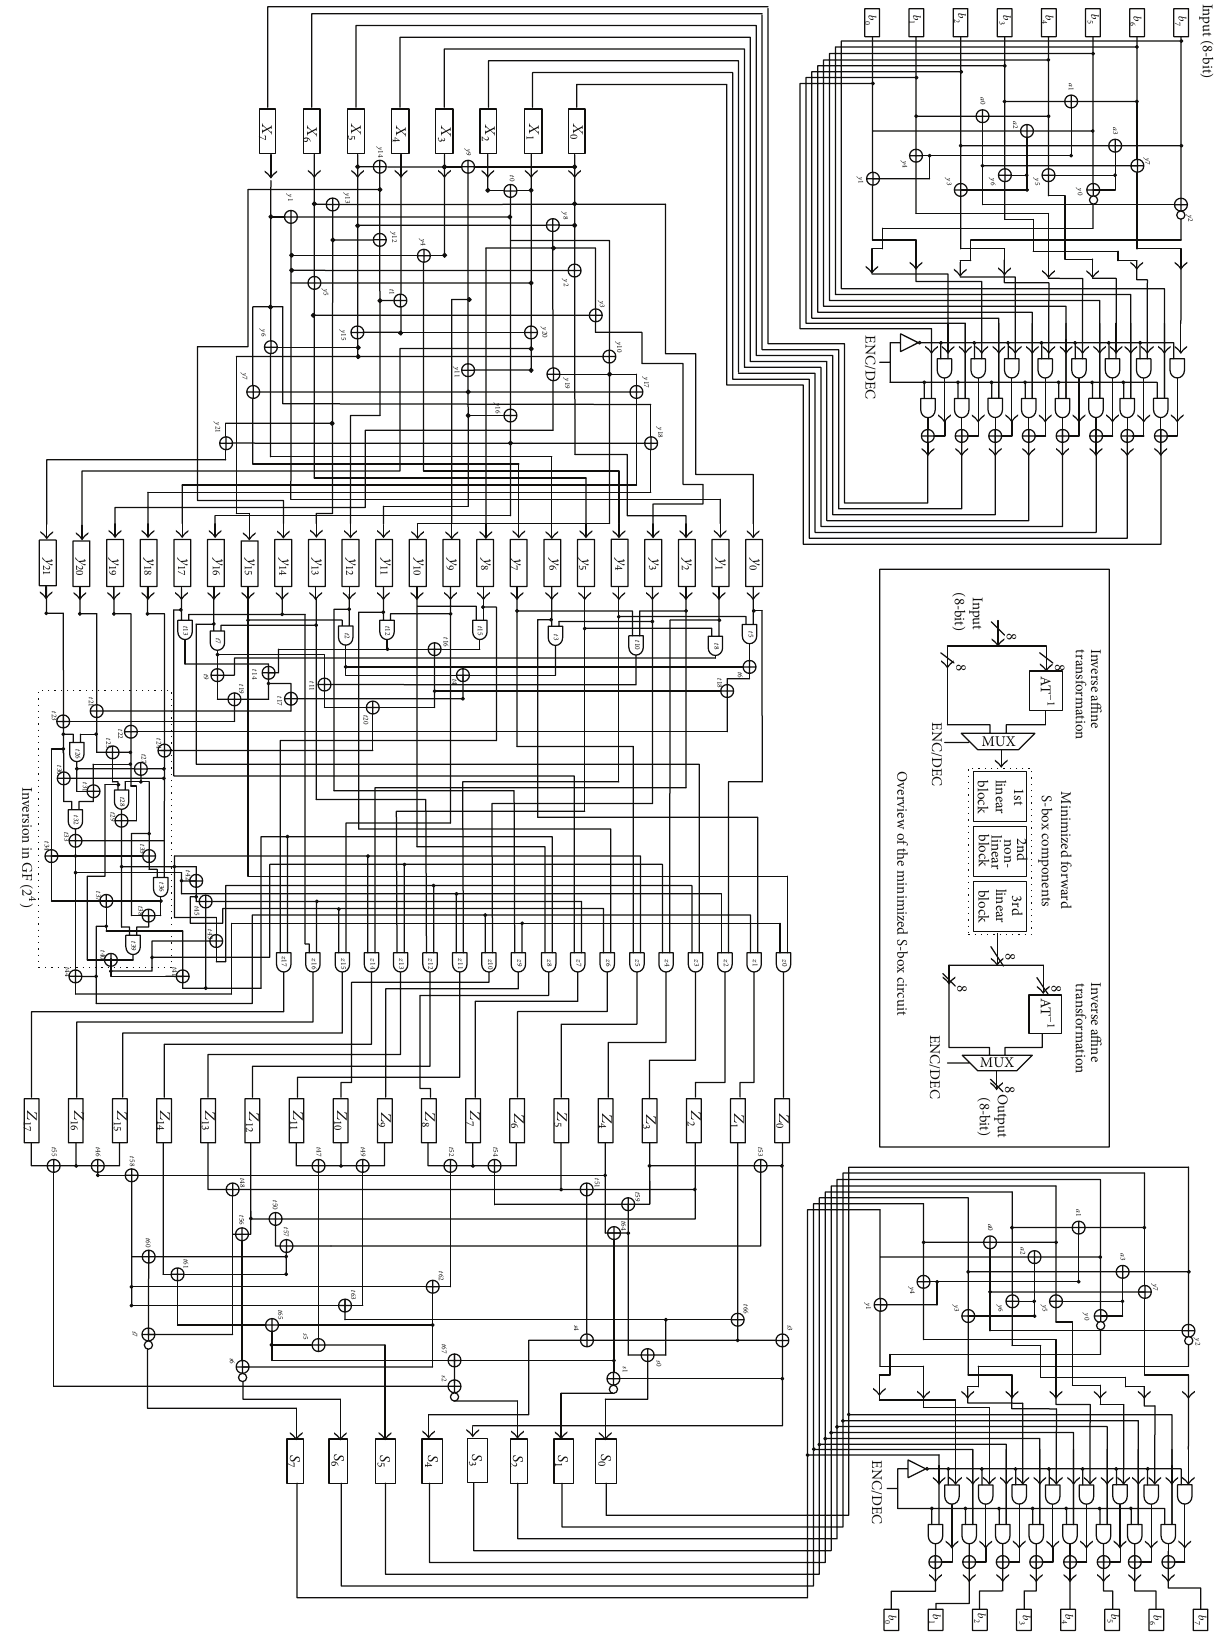
Figure 10: The complete gate layout of the proposed S-box configuration for bidirectional